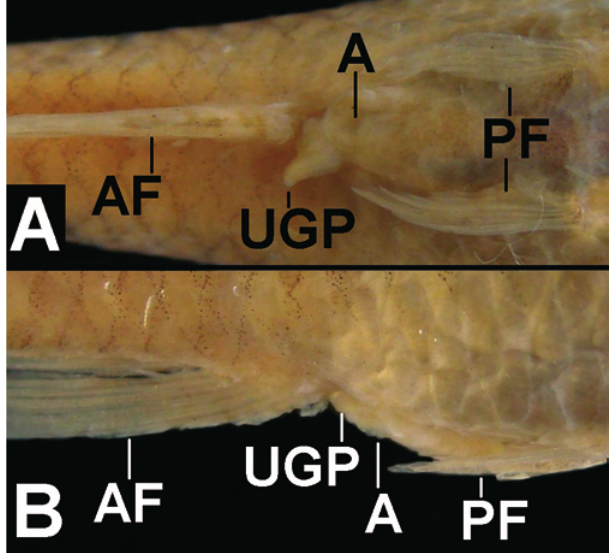
Fig. 16. Urogenital region of female of Phalloceros leptokeras , MCP 30512. (A) ventral view; (B) lateral view of left side. A = anus; AF = anal fin; PF = pelvic fin; UGP = urogenital papilla. Scale bar 1